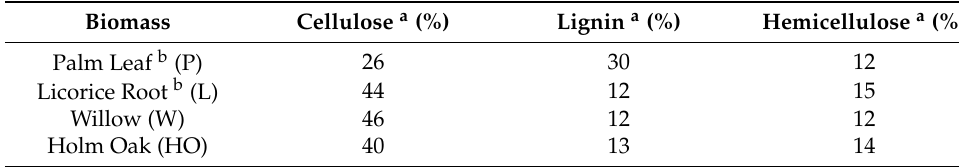
Table 1. Fractions of cellulose, lignin, and hemicellulose in biomasses, as